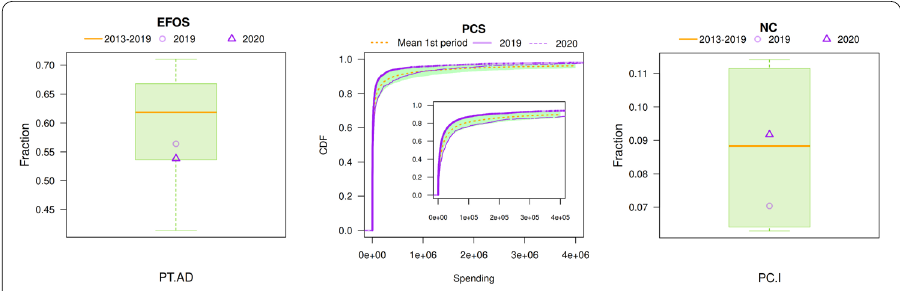
Figure 4 Example variables illustrating the main similarities between both government periods. Left: Similarities between contracts in the EFOS class. Fraction of contracts assigned to single-bidders ( PT.AD ) in the EFOS class. In green, boxplot of the 6 years comprising the 1st government period. Center: Similarities between contracts in the PCS class. CDF for the Spending variable. Inset: A close up to the behavior of the CDF for small values of the Spending variable. The green area represents the CI at 99% generated by the data of the 1st period. Right: Similarities between contracts in the NC class. Fraction of contracts in the NC class made under an international legal framework ( PC.I ). In all graphs, the orange line corresponds to the mean of the 1st government period, and two purple colored curves correspond to the first two years of the second government